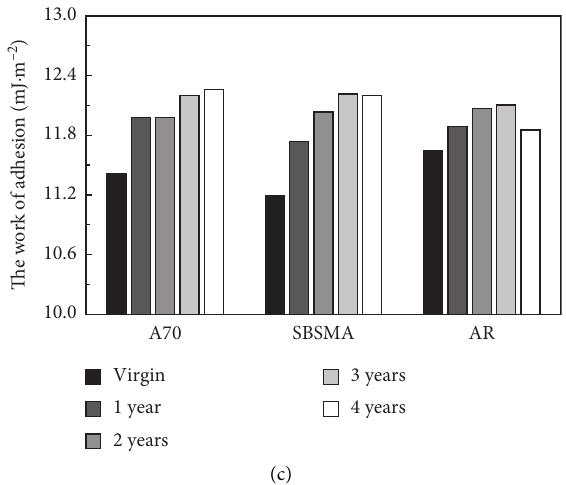
Figure 8: Work of adhesion with asphalt and (a) limestone, (b) basalt, and (c) granite under water